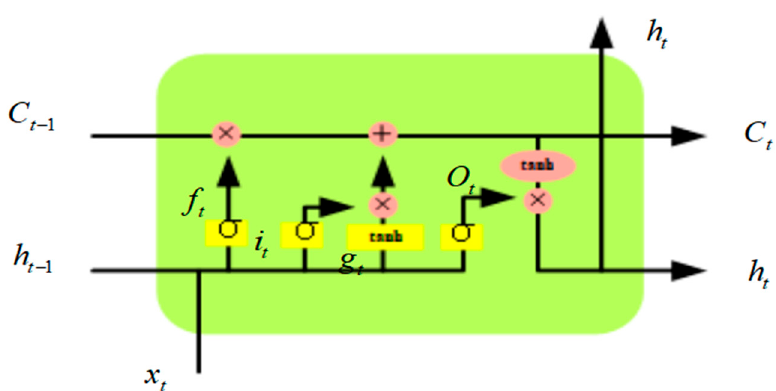
Figure 8. The logical processing unit of the LSTM neural network.